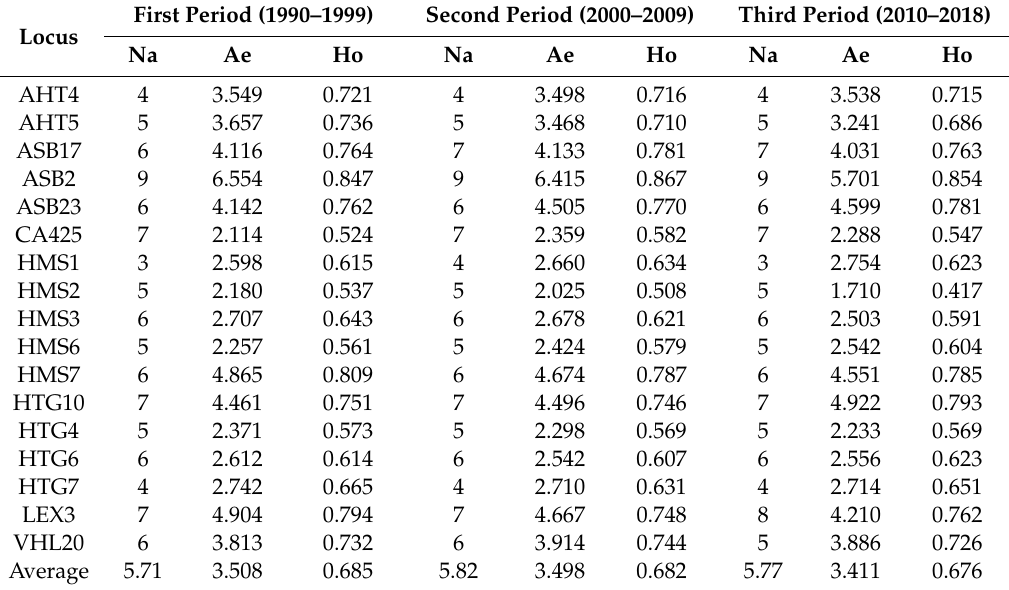
Table 2. The allele spectrum of microsatellite loci in TB horses in di ff erent periods. Locus